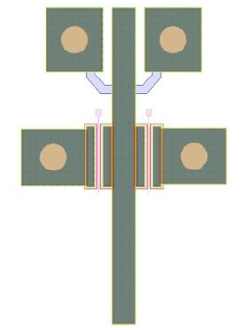
Fig. 4. The topology of matched LOAD. Simulated vs measured S11 and S22 are shown in fig. 5 and fig. 6.